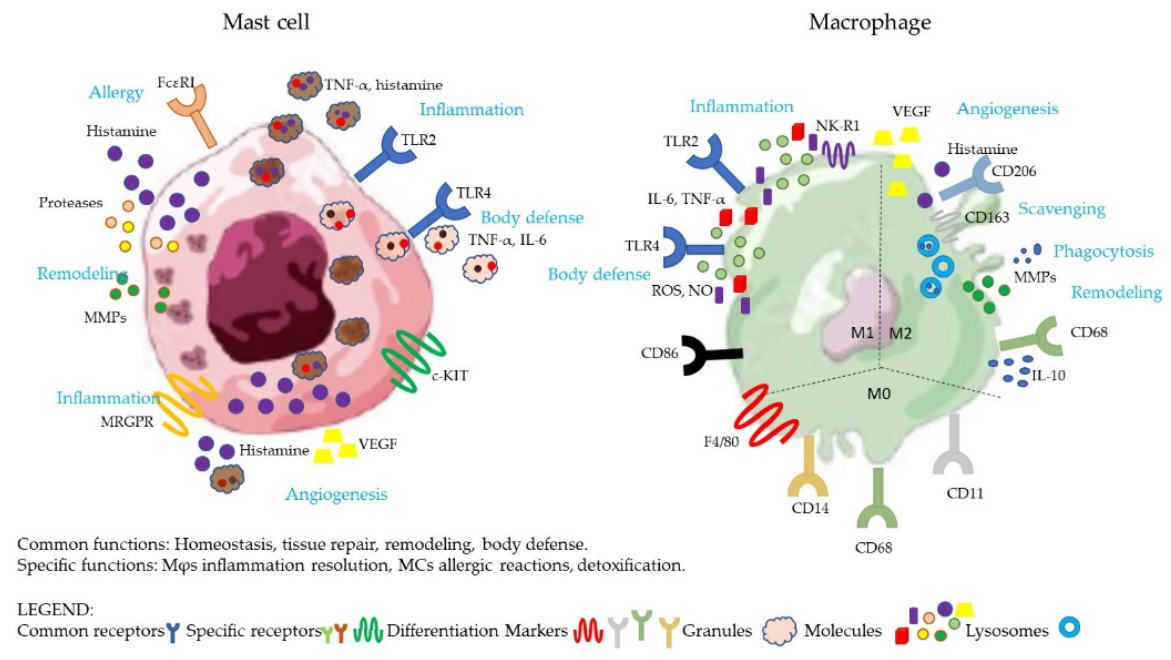
Figure 2. Representative picture of the main characteristics of MCs and M ϕ s listed in this review. The mediators, cytokines, and enzymes produced following the activation of the receptors present on the cells are shown in the figure and are described in the text of the review. This figure was generated with Adobe Illustrator and PowerPoint.